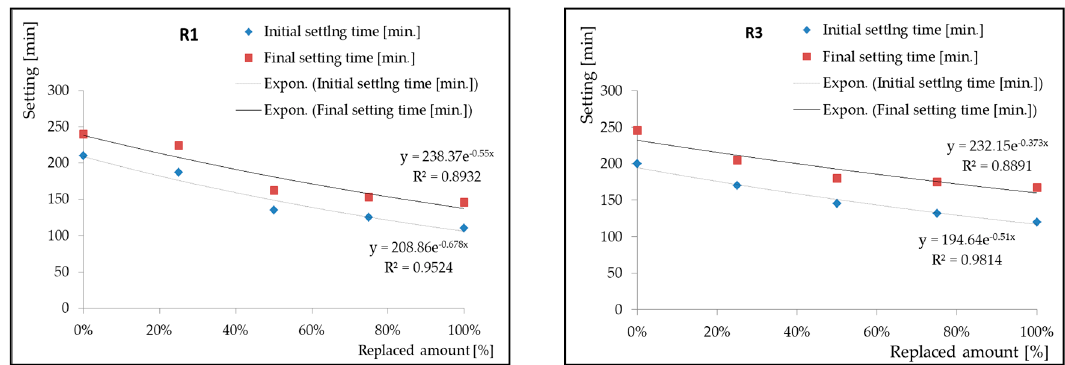
Figure 4. Exponential dependence of the initial and final setting time of Formulas R1 and R3.